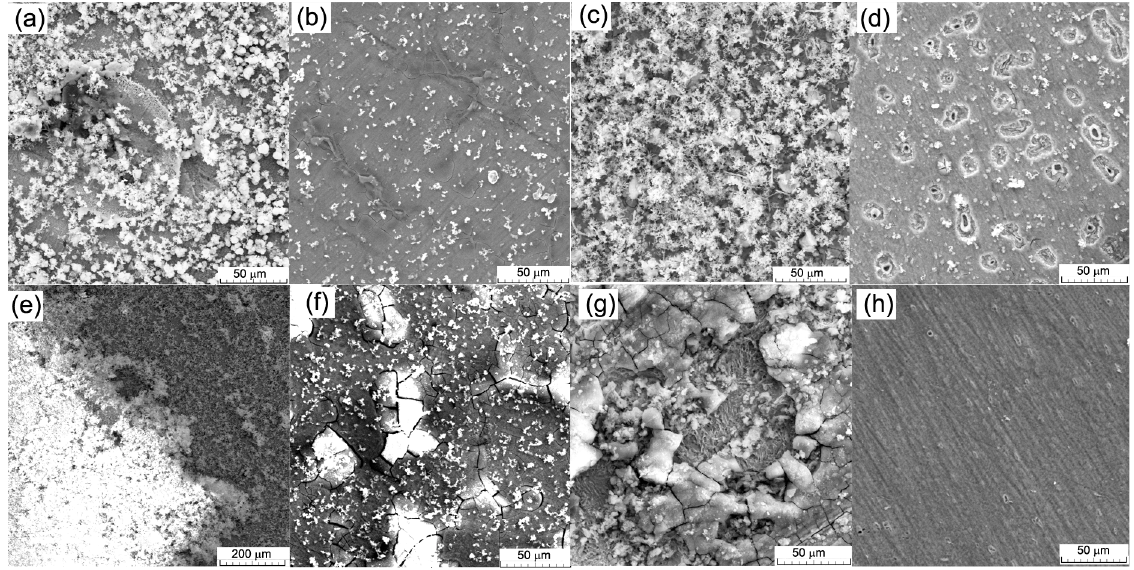
Figure 6. SEM images: ( a ) C sample after 1 day immersion (1 kx); ( b ) after ultrasound cleaning (5 kx); ( c ) HR sample after 1 day immersion (1 kx); ( d ) after ultrasound cleaning (5 kx); ( e ) C sample after 7 days immersion (1 kx); ( f ) and after ultrasound cleaning (2 kx); ( g ) HR sample after 7 days immersion (1 kx); ( h ) after ultrasound cleaning (2 kx).